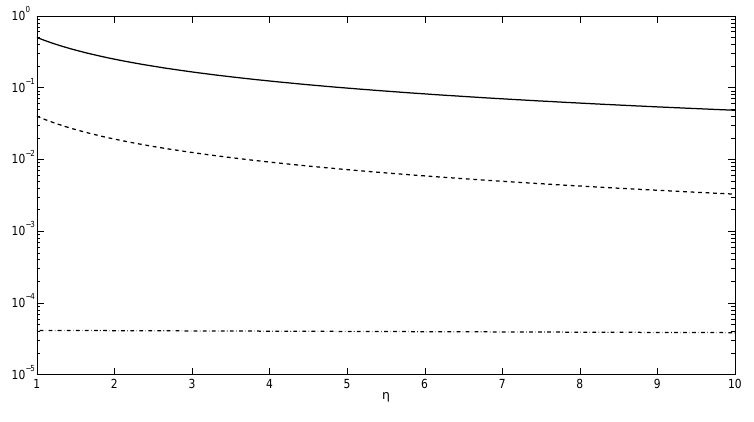
− σ 2 | (dashed line) and | (cid:101) µ − µ | (dashed-dotted V V